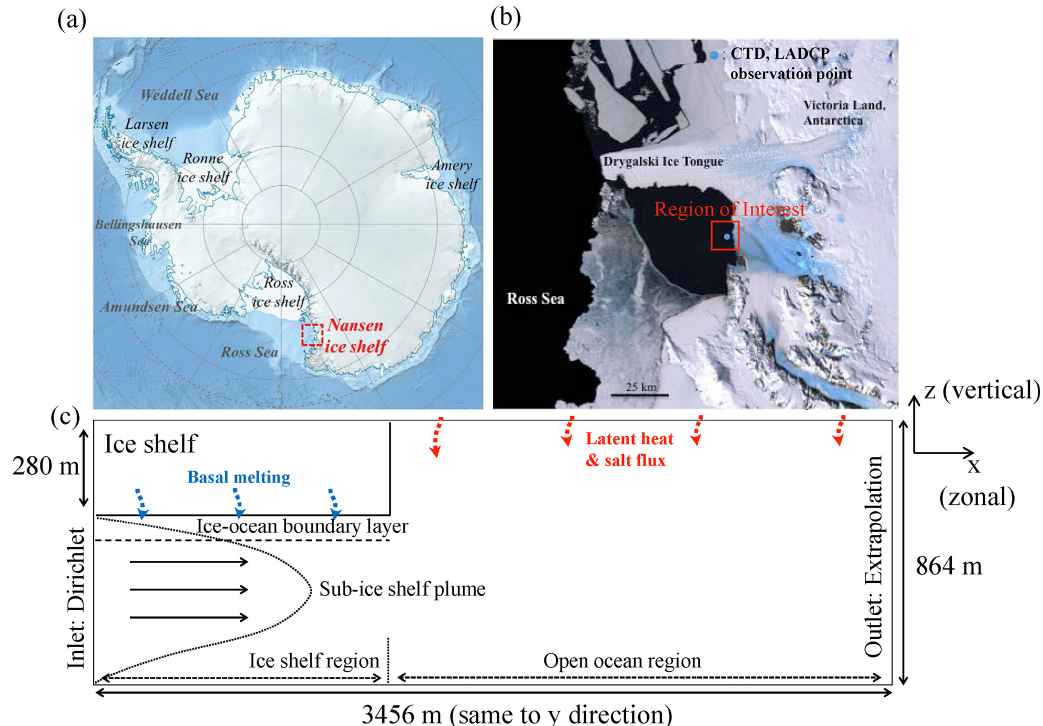
Figure 1. Region of interest and simulation domain configuration. (a) Map of Antarctica. The red box shows the study area, Terra Nova Bay, in the western Ross Sea. (b) Region of interest where the CTD and LADCP surveys were conducted in the 2016–2017 shipboard survey (satellite image was obtained from © Google Earth, 2020). (c) Simulation domain and boundary conditions.